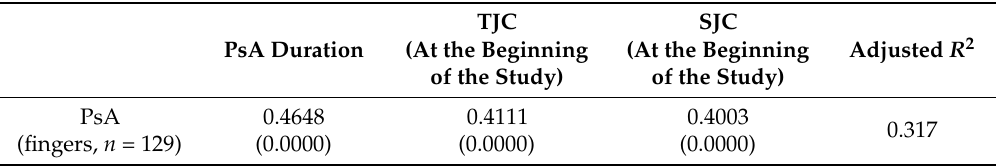
Table 7. The regression coefficients in modelling for finger extensor tendon thickness in psoriatic arthritis patients treated with